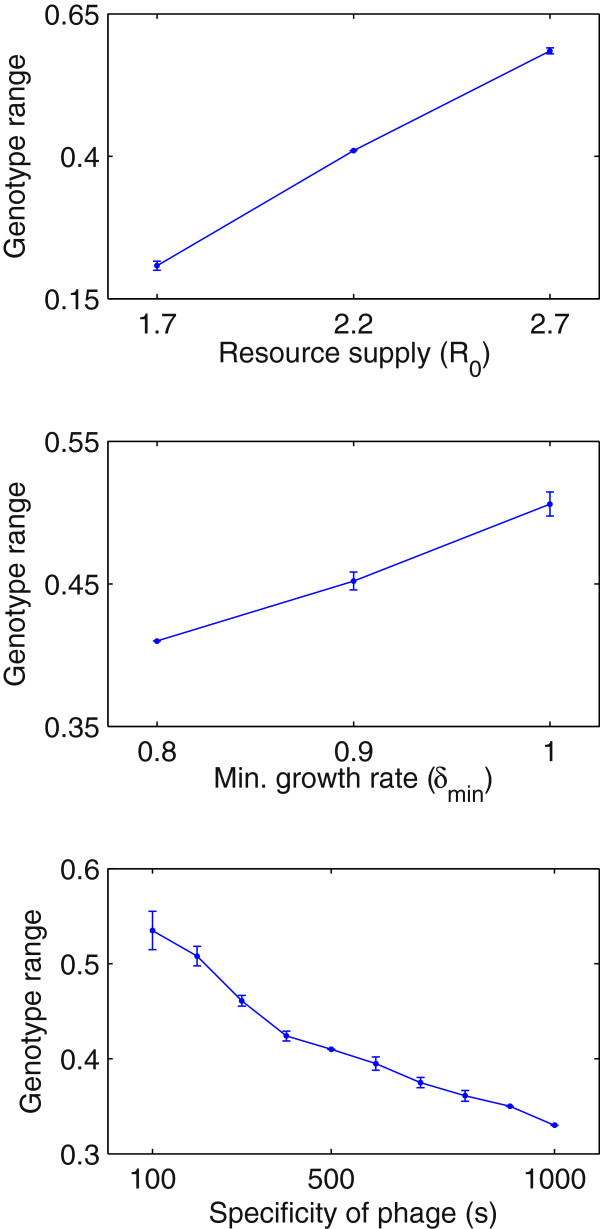
Sensitivity of host genotype variation to resource supplyR0, minimum growth rateδmin, and specificity of phages. Genotype range measured as difference between maximum and minimum values in final bacterial community from coevolutionary simulations on a single-peak landscape (e.g. Figure 2); mean±1s.d.plotted for 10-run ensembles for each parameter combination. Parameter settings as Table 1 except for manipulated variables R0∈{1.7,2.2,2.7}, δmin∈{0.8,0.9,1},s∈{100,200,..,1000} and hinit=vinit=0.5, T=5×106min, MB=MV=10−5.